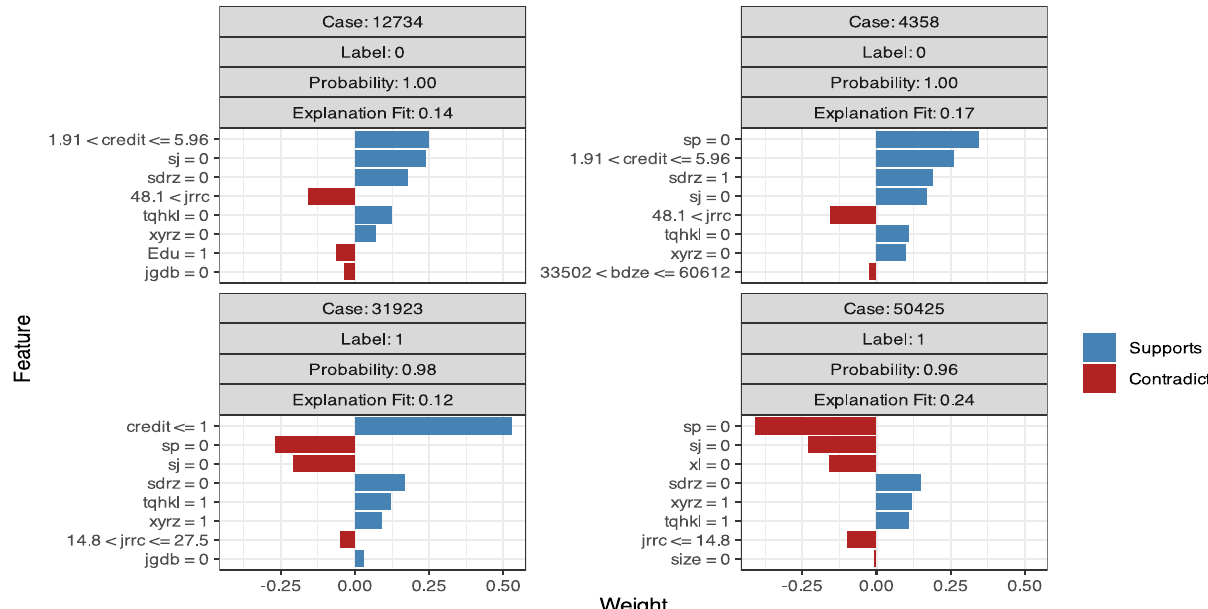
Figure 5. Variable weights of the NN model.